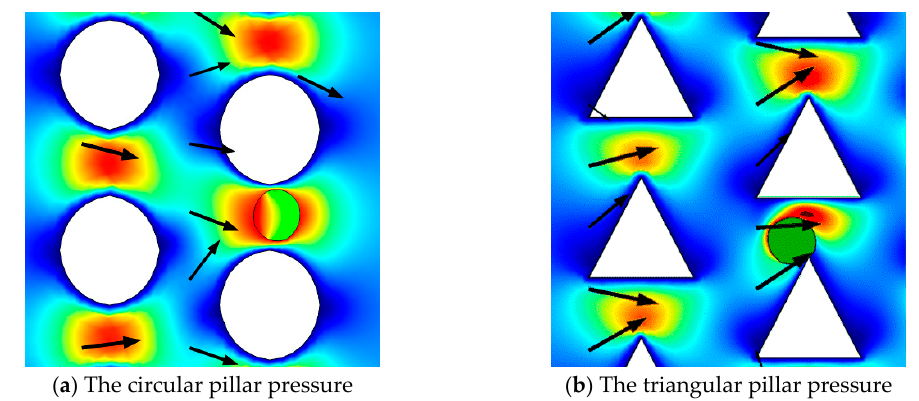
Figure 10. The movement of microspheres identical in size in two types of DLD devices.